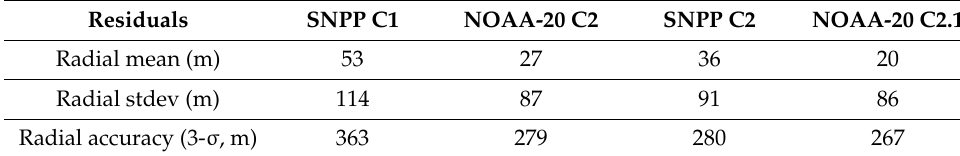
Table 4. Worst case 16-day statistics in geolocation error